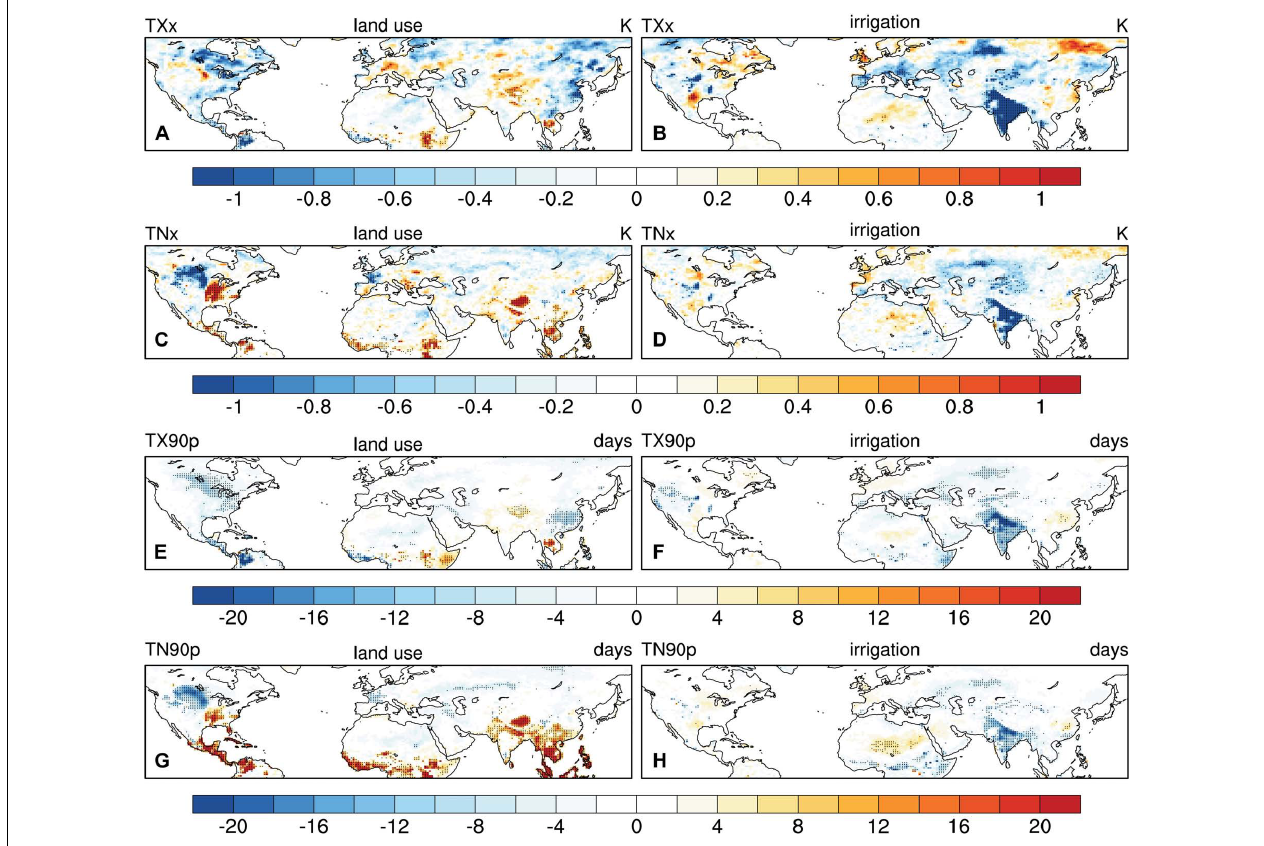
FIGURE 7 | Changes in warmest day [TXx in K, (A,B) ], warmest night [TNx in K, (C,D) ], number of warm days [TX90p in days, (E,F) ] and number of warm nights [TN90p in days, (G,H) ] due to historical land use (left) and irrigation (right). Stippling indicates significance at the 95% confidence